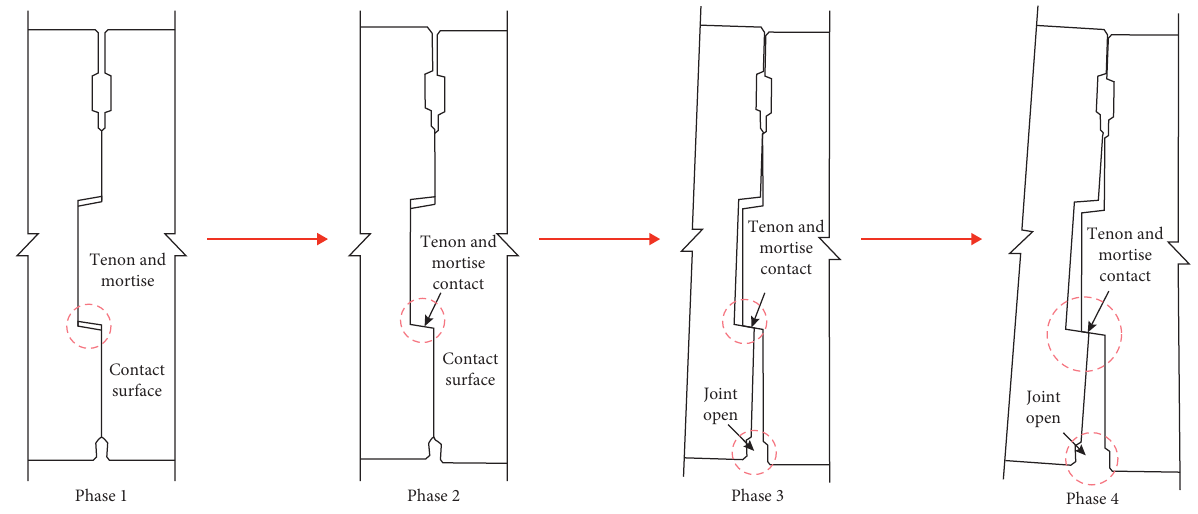
Figure 16: Schematic diagram of open